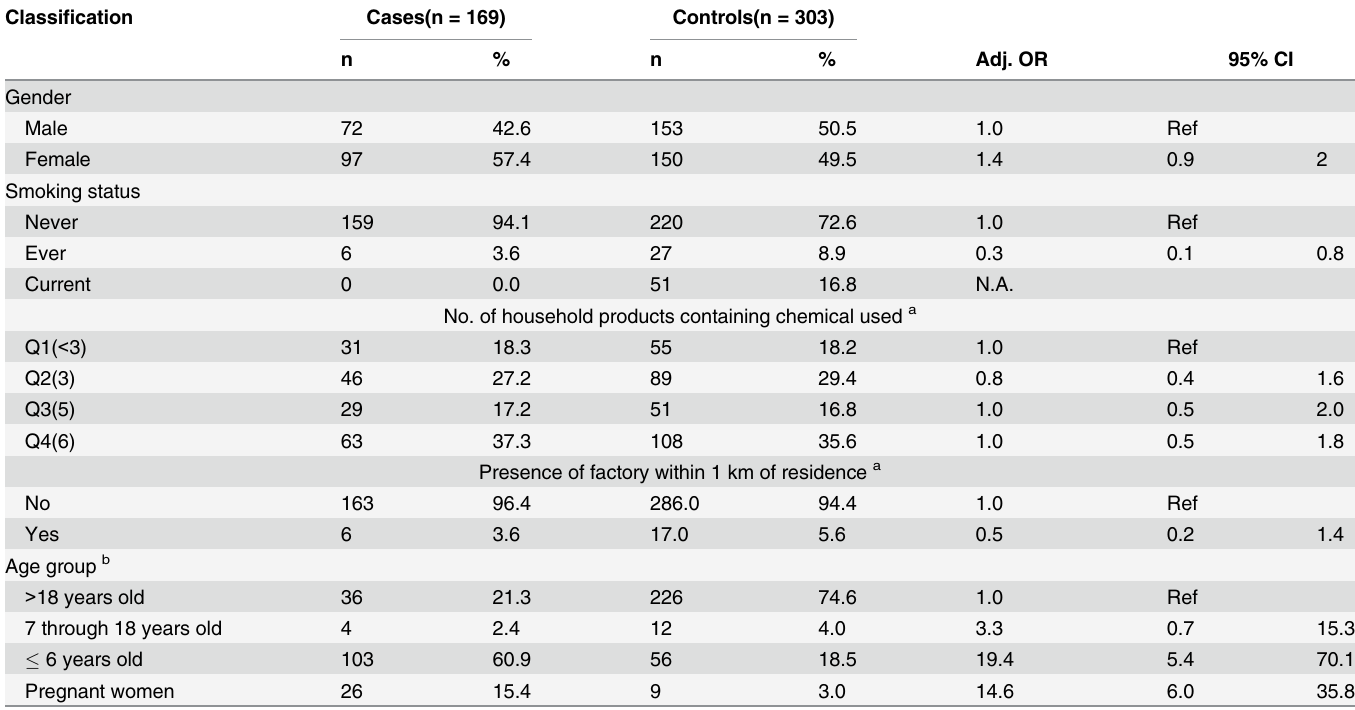
Table 1. Associations with HDLI for confounding